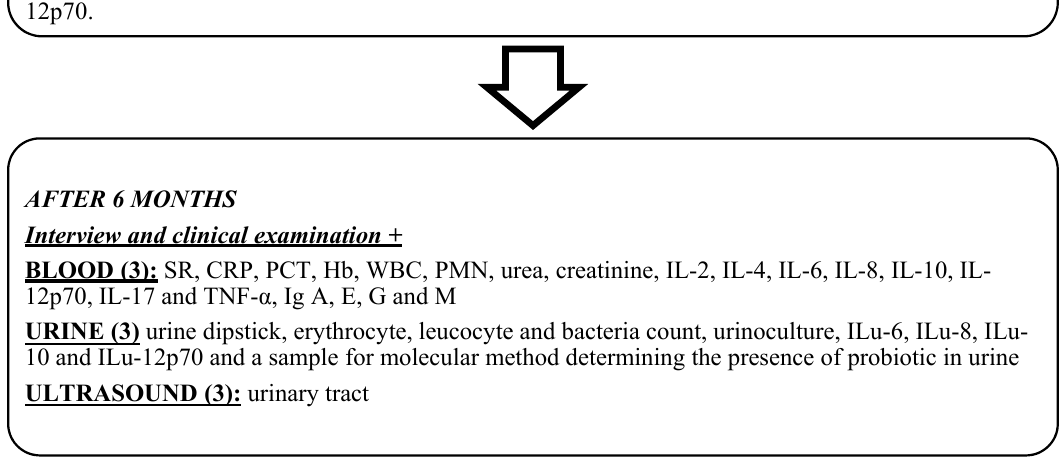
Figure 1. Flowchart of present study design and workflow. SR—sedimentation rate, CRP—C-reactive protein, PCT—procalcitonin, Hb—haemoglobin, WBC—white blood cell count, PMC—% polimorphonuclear cells, IL-2—interleukin-2, IL-4—interleukin-4, IL-6—interleukin-6, IL-8—interleukin-8, IL-10—interleukin-10, IL-12p70—interleukin-12p70, IL-17—interleukin-17, TNF ɑ - tumor necrosis factor alpha, Ilu-6—urinary interleukin-6, Ilu-8—urinary interleukin-8, Ilu10—urinary interleukin-10, Ilu12p70—urinary interleukin-12p70, US—ultrasound, IgA, E, G, M—inmmunoglobulin A, E, G, M.